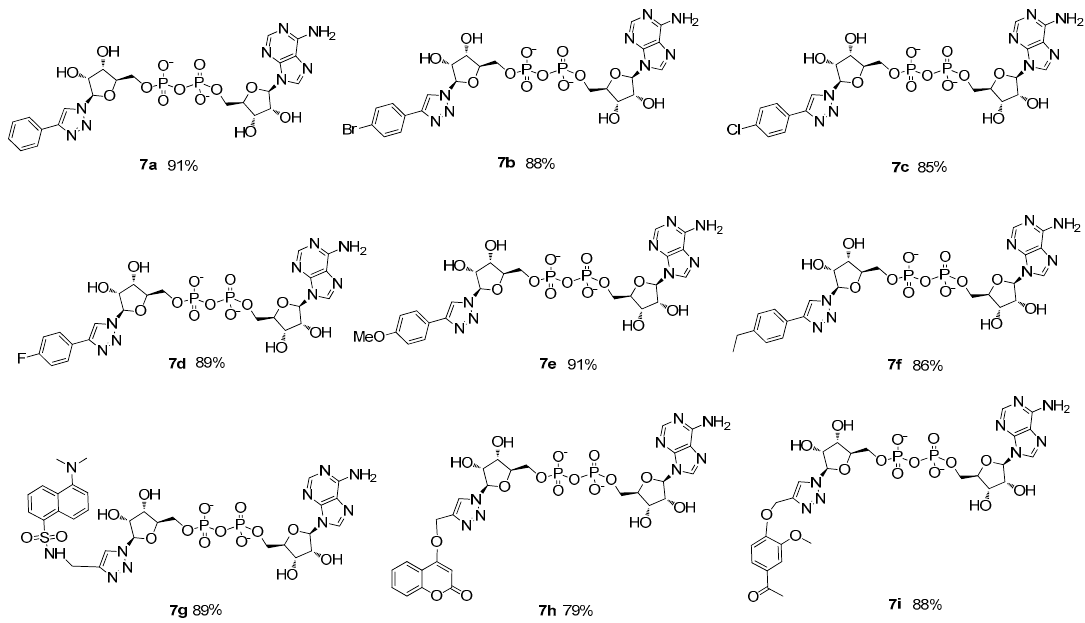
Figure 3. ADP-ribosylated compounds synthesized via divergent strategy (1,2) . 1 ADP-ribosyl-N 3 (0.01 mmol), terminal alkynes (0.012 mmol), 10 mol % CuSO 4 and Cu(0) (copper sheet) were added in